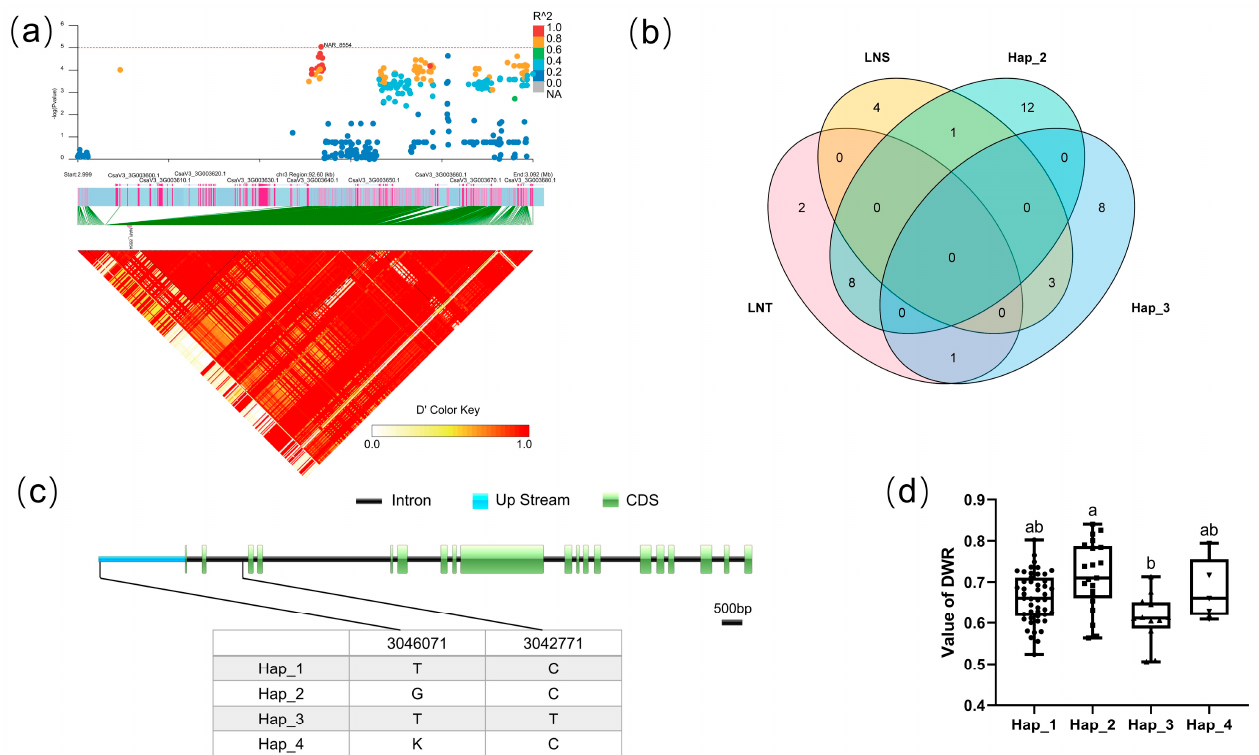
Figure 4. Identification of the low-nitrate tolerance gene at block 8554. ( a ) Manhattan map (top) and LD heatmap (bottom) of the block 8554. ( b ) Hap_3 and Hap_2 of CsaV3_3G003630 in LNS and LNR. ( c ) SNP variation of the candidate gene CsaV3_3G003630 among four haplotypes. ( d ) Haplotype difference of CsaV3_3G003630, different letters meant there was significant difference among groups (p < 0.05).